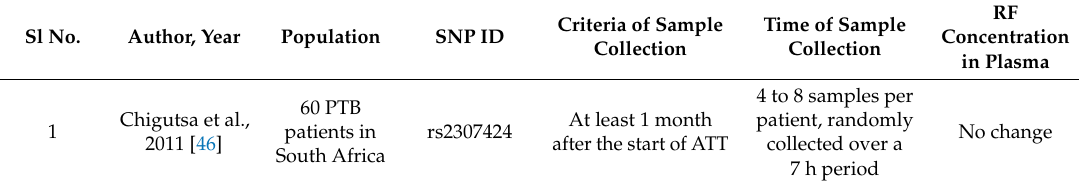
Table 4. Influence of CAR genetic variants on plasma RF